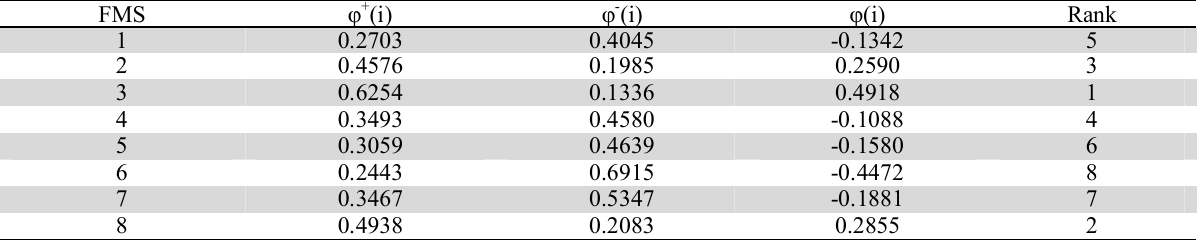
Leaving flow, entering flow and net outranking flow values in EXPROM2